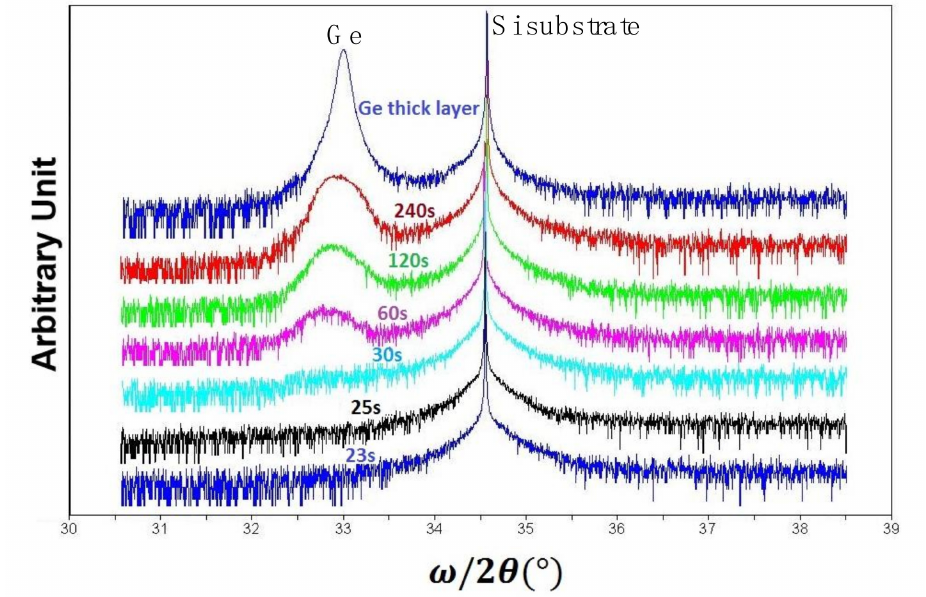
Figure 5. High resolution X-ray diffraction (HRXRD) omega-2theta (004) rocking curves for different Ge deposition